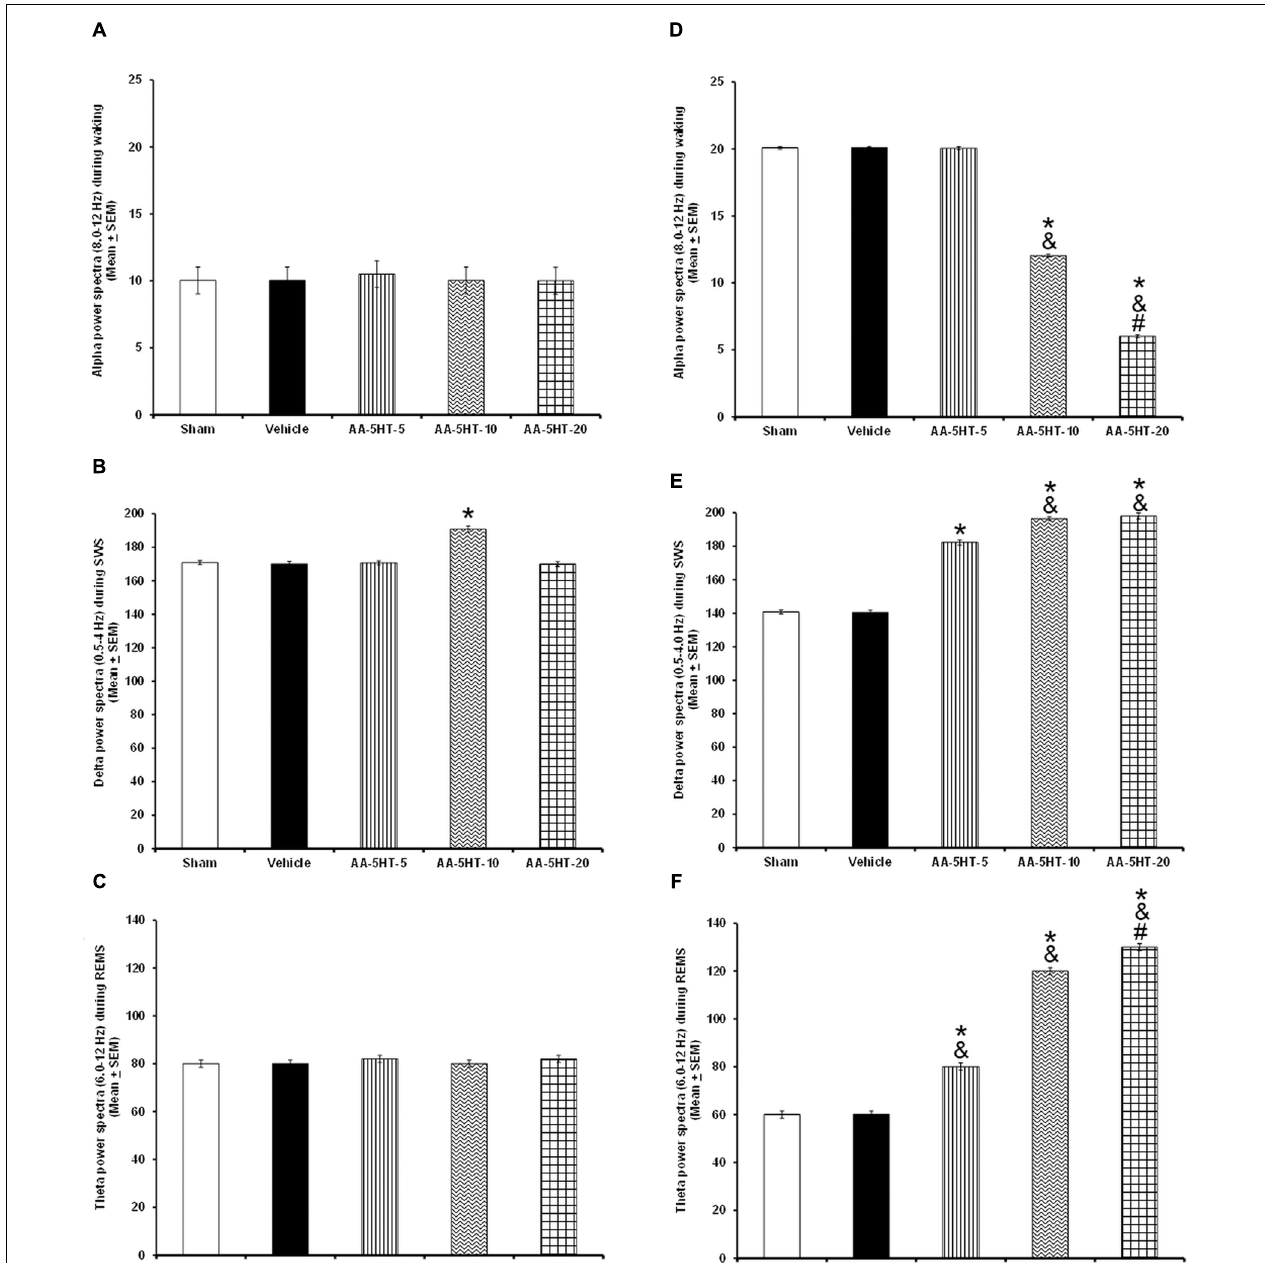
FIGURE 2 | Effects on EEG power spectra (alpha, delta or theta) after experimental trials: Sham, vehicle or AA-5-HT (5, 10, or 20 mg/Kg; i.p.). No effects were observed in alpha or theta power spectra when AA-5-HT was injected during the lights-on period. (A–C) respectively). Next, when AA-5-HT was administered at the beginning of the lights-off period, the compound decreased alpha (for W: α = 8–12 Hz), and enhanced delta (for SWS: (cid:49) = 0.5–4.0 Hz) as well as theta (for REMS: (cid:50) = 6.0–12.0 Hz; (D–F) . Mean ± SEM ∗ vs Sham/Vehicle, P < 0.05; & vs. AA-5-HT-5, P < 0.05; # vs. AA-5-HT-10, P < 0.05). Abbreviations: slow wave sleep (SWS) and rapid eye movement sleep (REMS), AA-5-HT-5 mg/Kg (AA-5-HT-5), AA-5-HT-10 mg/Kg (AA-5HT-10), AA-5-HT-20 mg/Kg